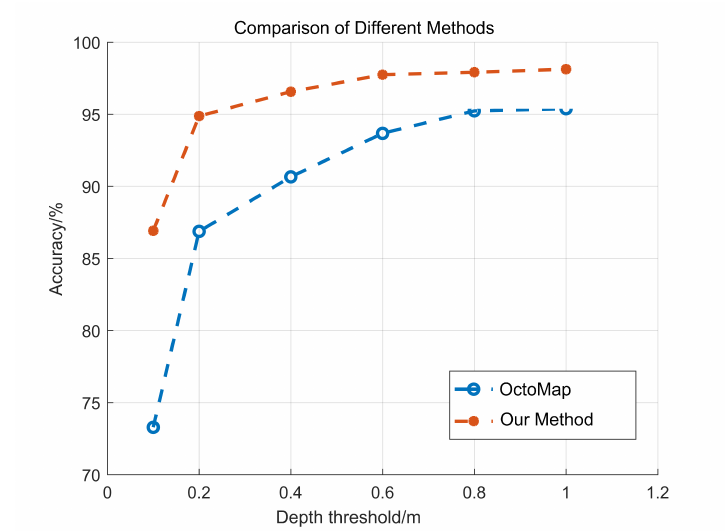
Figure 8. Qualitative comparison of reconstruction result between our methods and OctoMap [4] under different depth